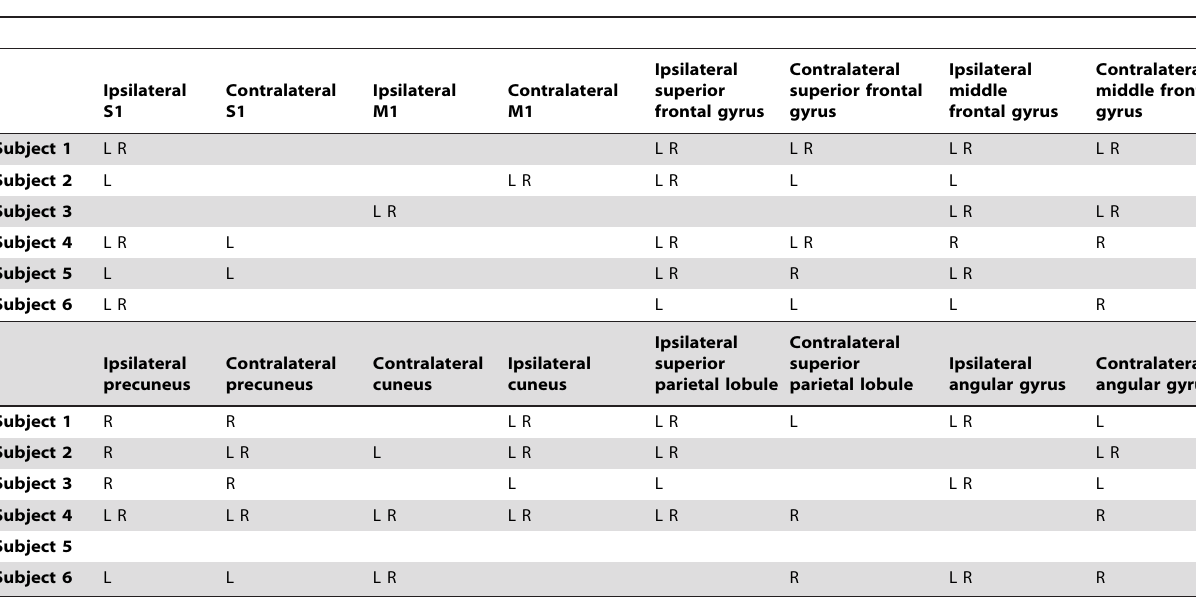
Table 2. sNBR foci detected in bilateral hand